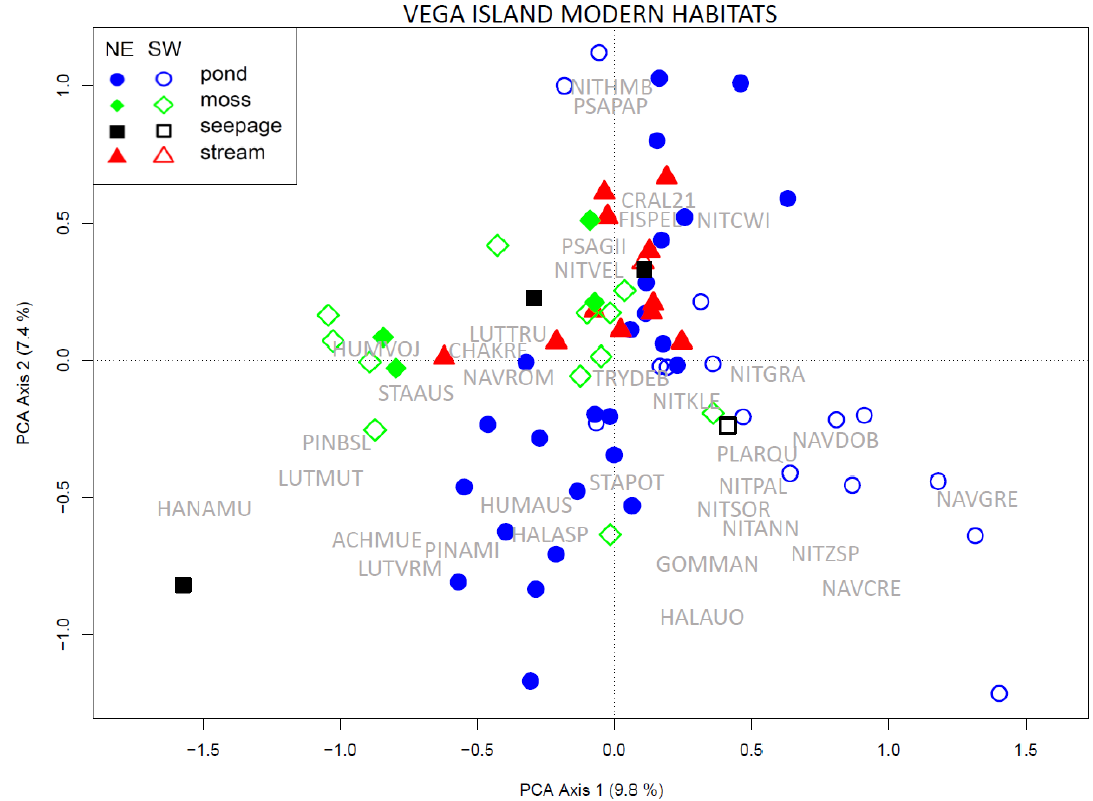
Figure 6. Principle components analysis (PCA) of the recent diatom community dataset from Vega Island, including all taxa with a relative abundance > 4% in at least one sample. Pond habitats are indicated by blue circles, moss habitats by green diamonds, seepages by black squares, and streams by red triangles. Symbols for Devil’s Bay are filled, and Cape Lamb sites are represented by outlines only. Diatom species with a relative abundance > 10% in at least one sample are superimposed, and the key for species abbreviations is given in Table S2.